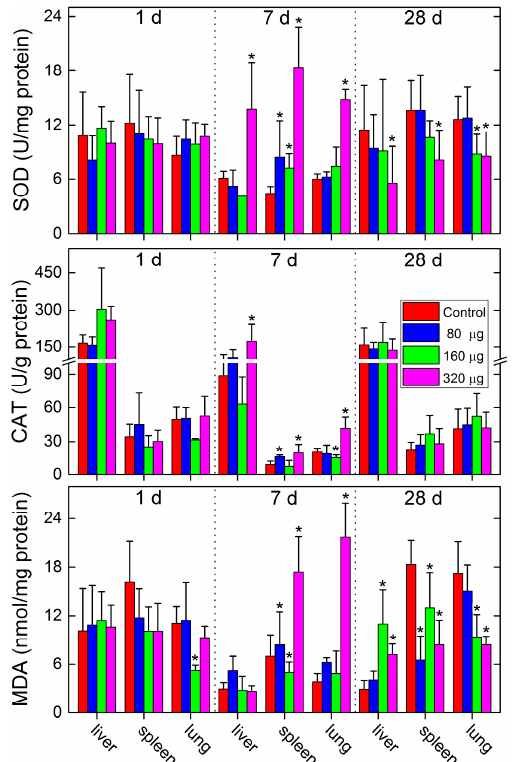
Figure 6. Oxidative stress levels of the mice exposed to CNSI post intravenous exposure. Data represent means ± SD ( n = 5). * p < 0.05 compared with the control group.